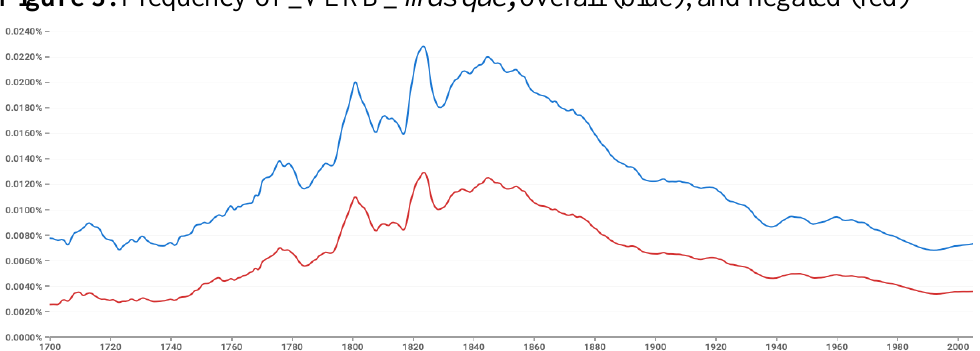
Figure 3. Frequency of _VERB_ más que, overall (blue), and negated (red) 13